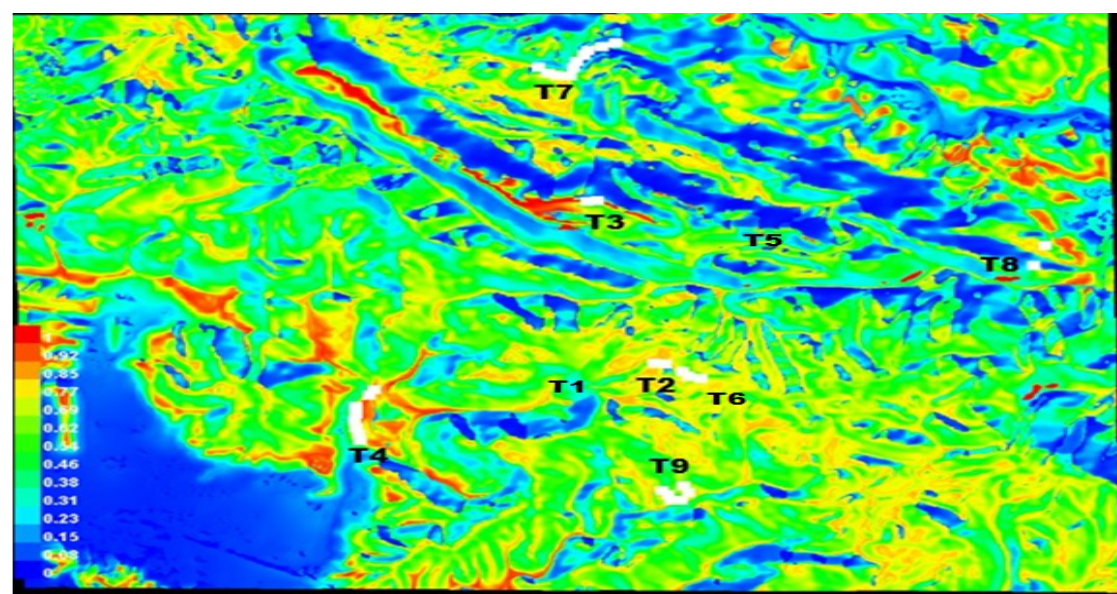
Fig. 3: Predicted conditions to IAPS. White dots show the PO data. Warmer colours indicate the most suitable predicted conditions (MaxEnt3.4.1